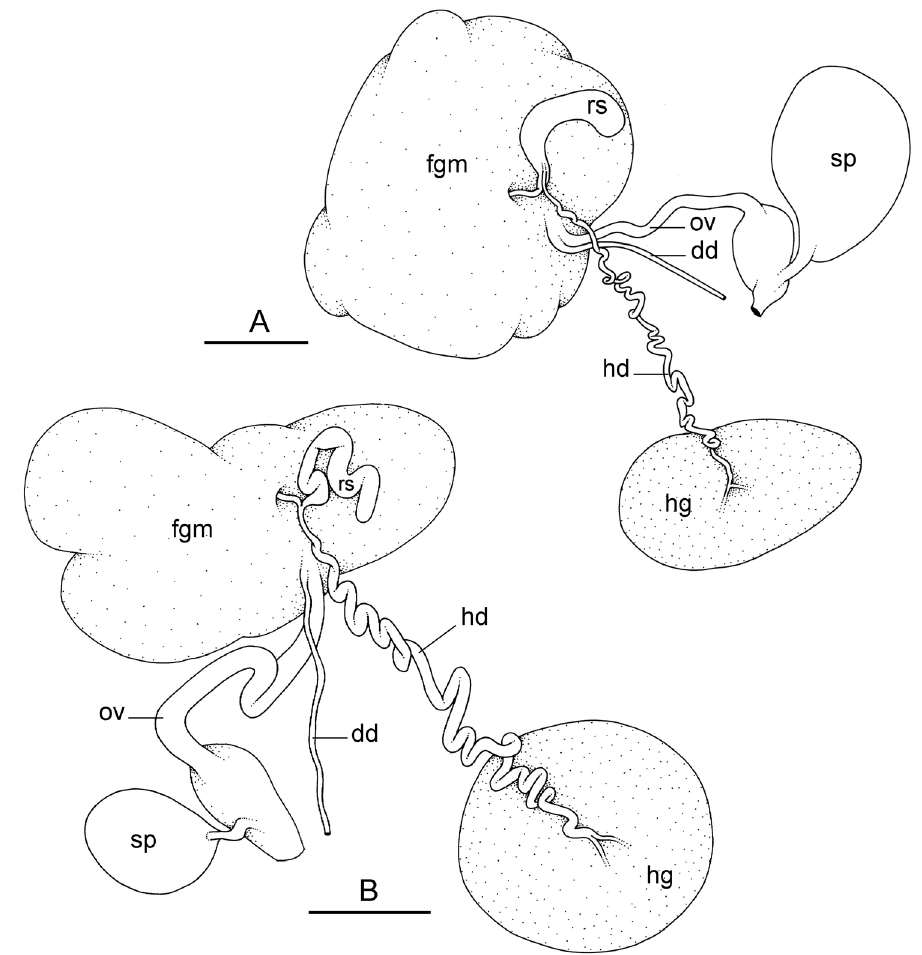
Figure 46. Reproductive system, Hermaphroditic (female), posterior parts, Wallaconchis graniferum , Philippines. A Luzon, scale bar 5 mm [3163] (PNM 041227) B Bohol, scale bar 2 mm [3638] (PNM 041225). Abbreviations: dd deferent duct fgm female gland mass hd hermaphroditic duct hg hermaph- roditic gland ov oviduct rs receptaculum seminis sp